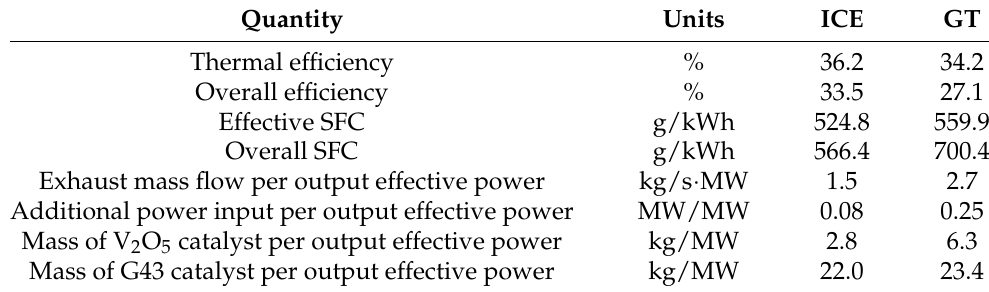
Table 13. A comparison of the average performance of ammonia-fuelled ICEs and GTs per effective output